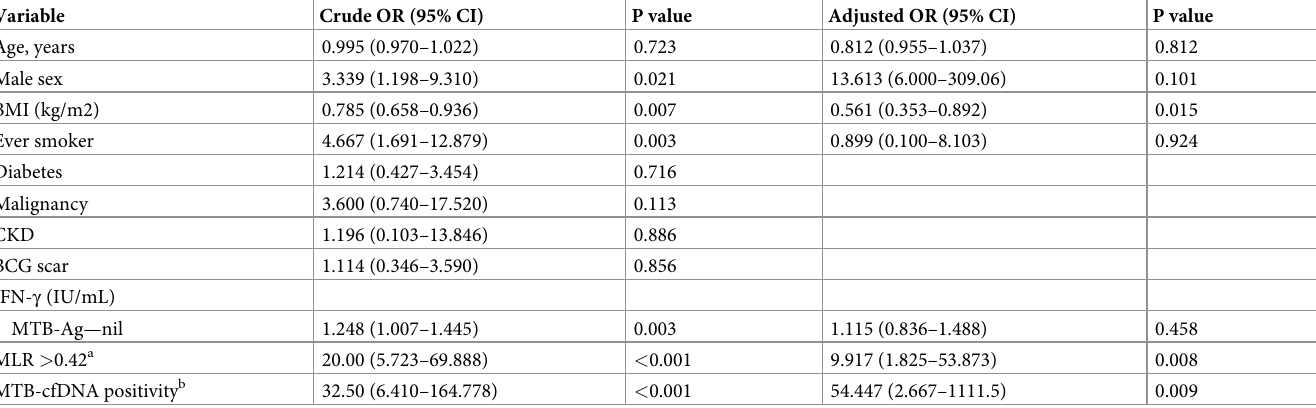
Table 3. Analysis of independent factors for discriminating patients with PTB and controls with